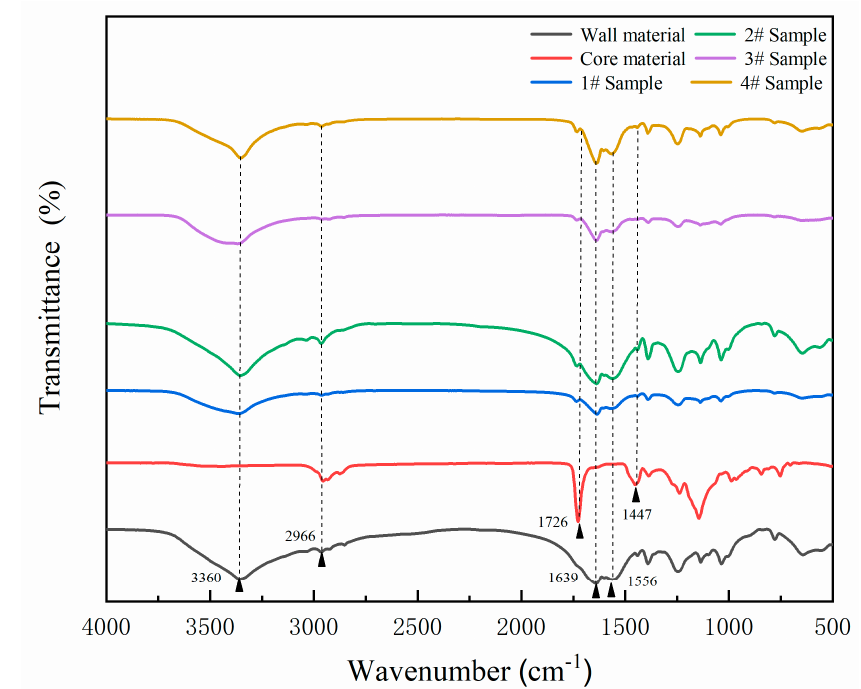
Figure 2. The infrared spectrum of wall material, core material and samples 1–4# of microcapsule.